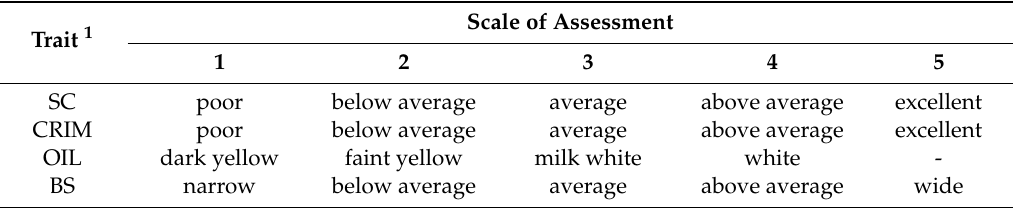
Table 1. Scale used for the subjectively-assessed wool traits in Merino sheep. Scale of Assessment Trait 1 1 2 3 4 5 SC poor below average average above average excellent CRIM poor below average average above average excellent OIL dark yellow faint yellow milk white white - BS narrow below average average above average